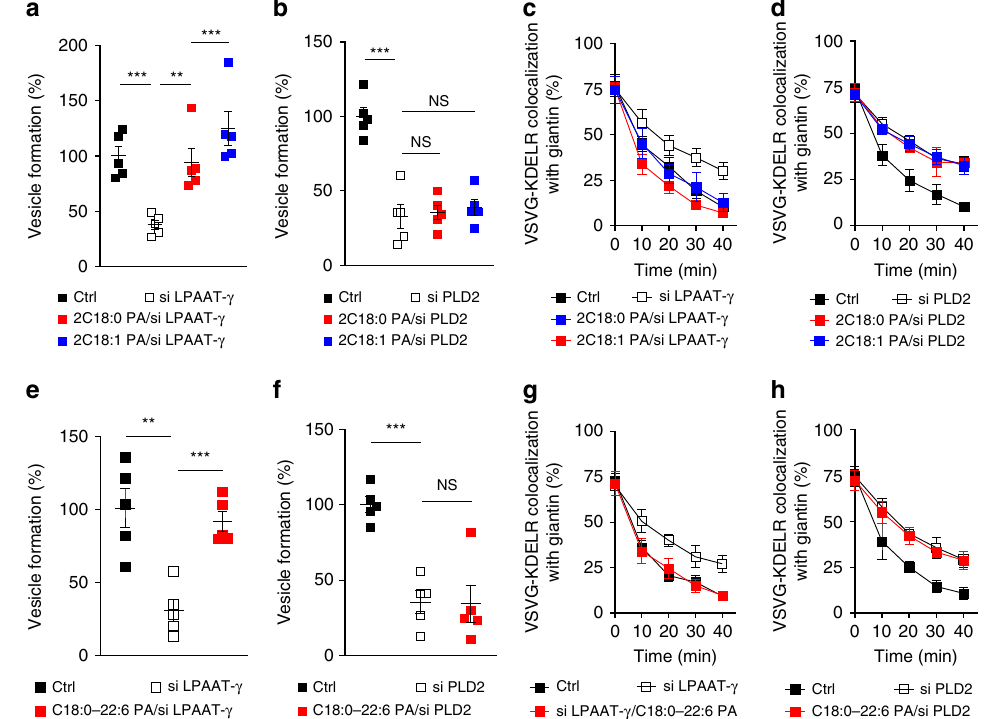
Fig. 1 Phosphatidic acid (PA) in early Coat Protein I (COPI) vesicle fi ssion. Quantitative data are shown as mean ± s.e.m. Signi fi cance was tested using